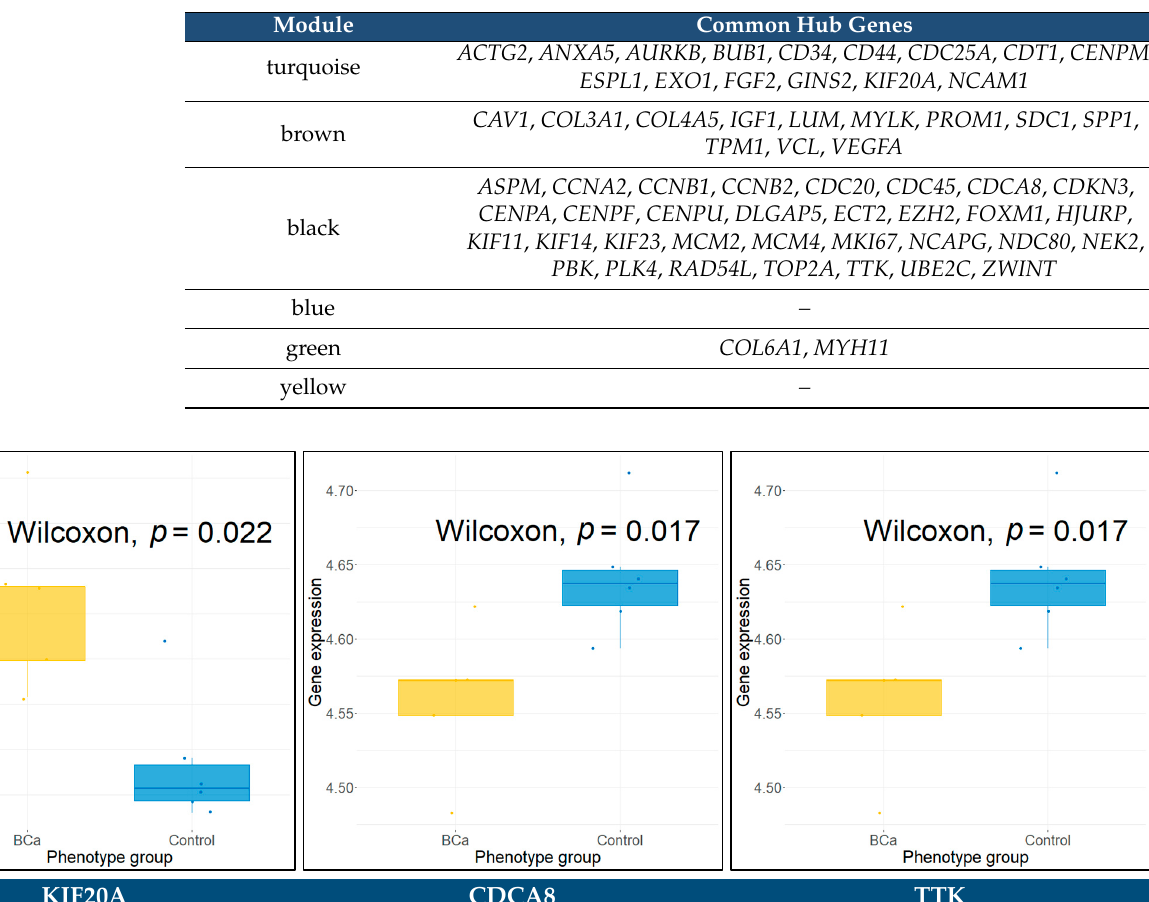
Table 4. The key hub genes of our study are defined as the intersection of hub genes between PPI network analysis and WGCNA.